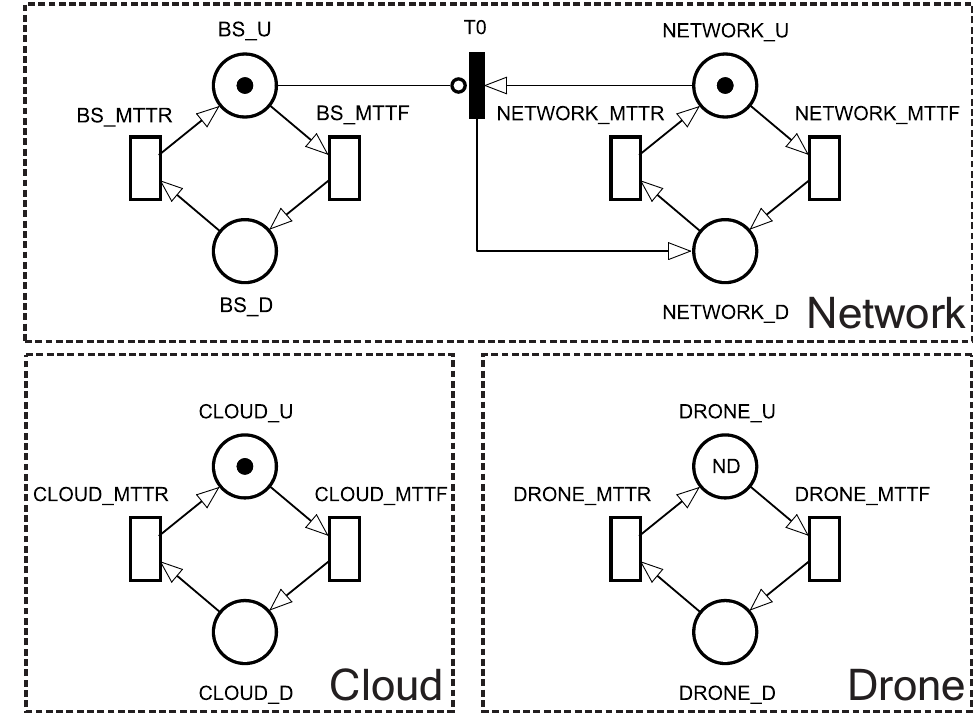
Figure 5. SPN base